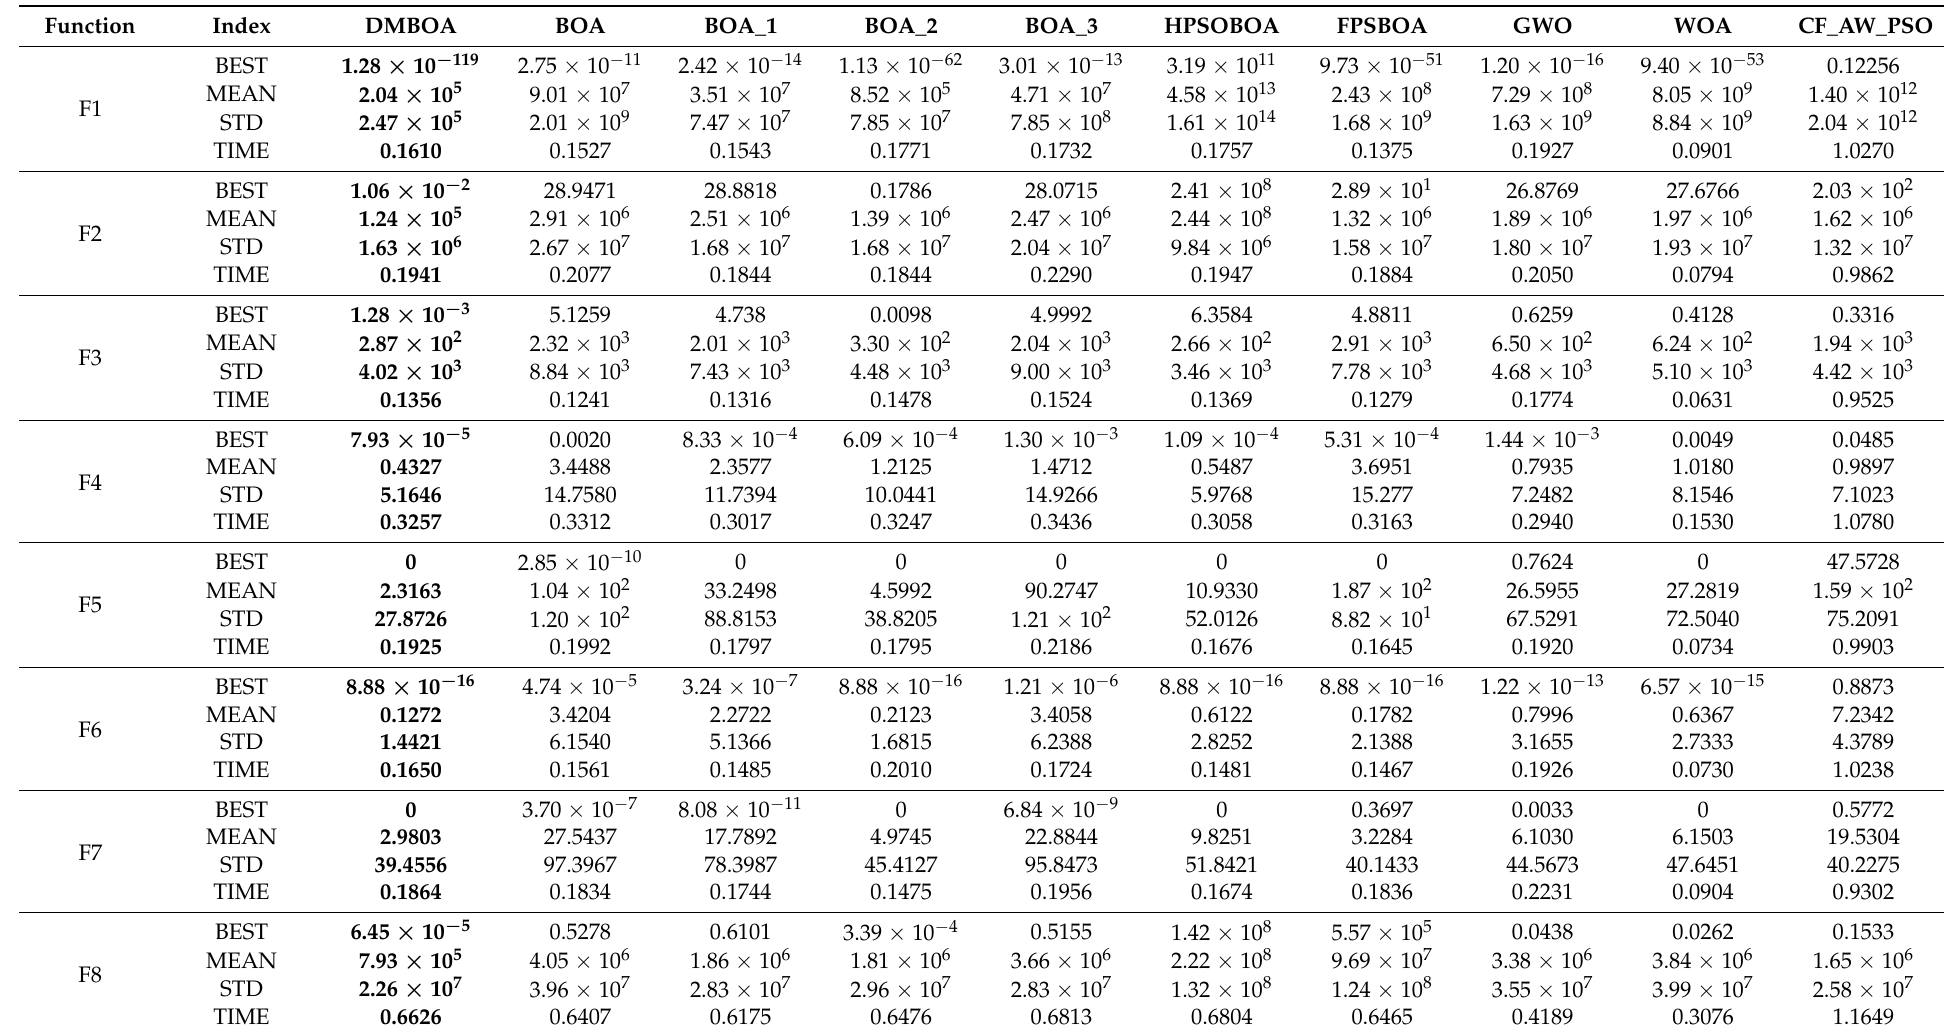
Table 3. Comparative analysis of performance of 10 swarm intelligence